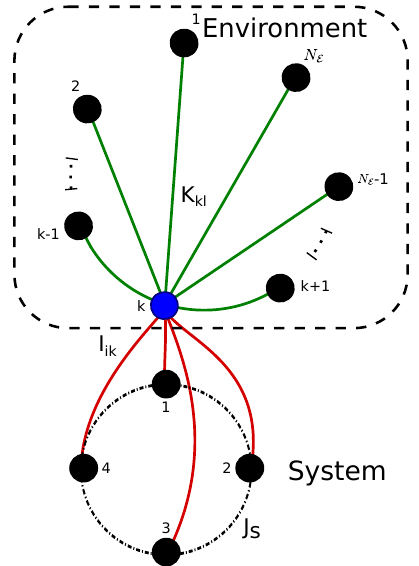
Figure 1: Schematic set-up of the spin-spin interactions as described by the Hamiltonian H , Eq. (4). A single representative environment particle, k , is highlighted (in blue) to illustrate the intra-environment coupling (green solid lines) and the coupling to the central-system (red solid lines). Each solid line denotes an antiferromagnetic interaction of random strength. All other environment particles have analogous coupling as illustrated by particle k . The dot- dashed lines in the central-system represent the nearest-neighbour coupling in H strength J S